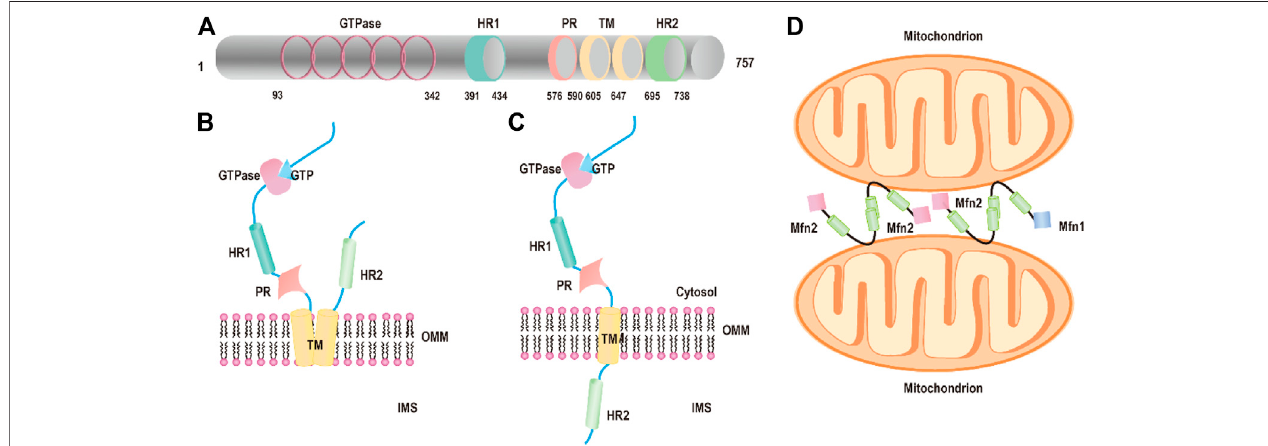
FIGURE1| StructureofMfn2. (A) Thefunctionaldomainsofmitofusin2:theGTPasedomains, heptadrepeat(HR)coiled-coilregions1and2,thePRdomain,and the transmembrane (TM) domain. (B) Schematic diagram ofMfn2 topology: P21 RAS domain, aproline-rich (PR) domain, the GTPase, and coiled-coil domains (HR1 and HR2)are exposed tothecytosoland transmembranedomains crossethe OMM. (C) Schematic diagram ofrevised Mfn2 topology: P21 RAS domain, aGTPase, acoiled- coil(HR1),andaproline-rich(PR)domainareexposedintothecytosol,atransmembranedomainspanstheOMM,andasecondcoiled-coil(HR)C-terminaldomain protrudes into the IMS. (D) Mitochondrial tethering is mediated by Mfn2 or